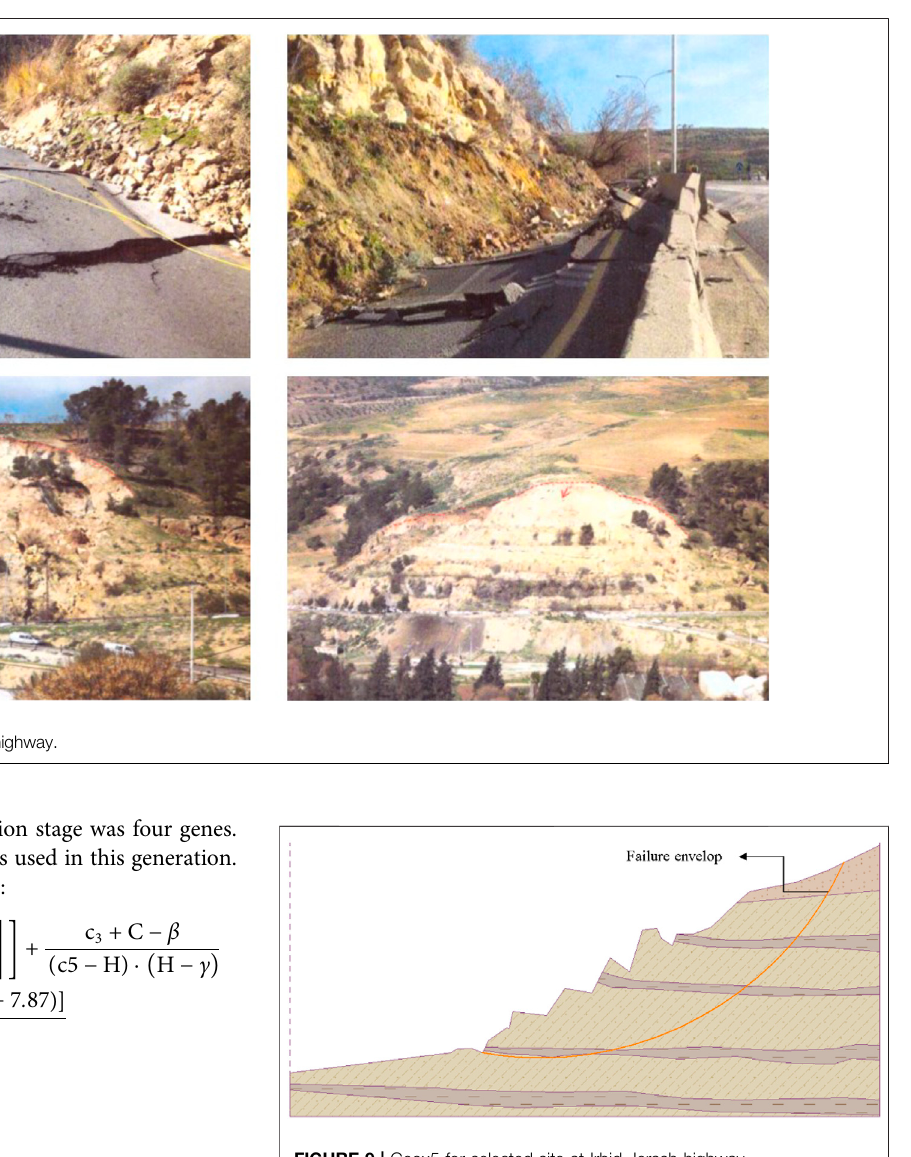
FIGURE 9 | Geox5 for selected site at Irbid Jerash